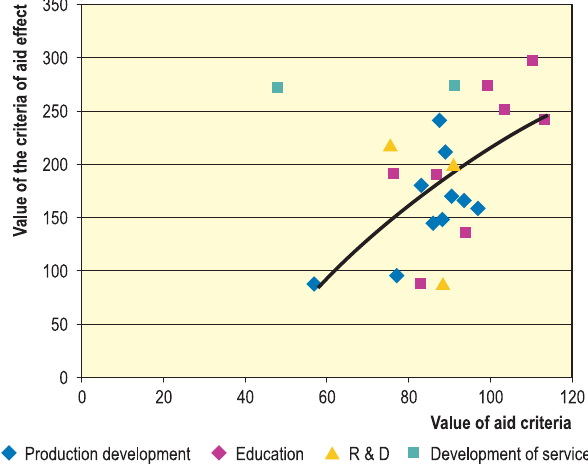
Fig. 1. The effect of aid to enterprises according to the areas of their activities calculated by SAW (correlation coeffi cient – 0.62)